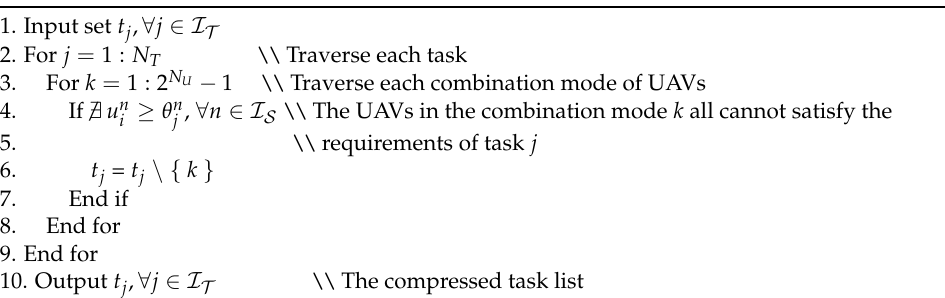
Algorithm 1 Solution space compression